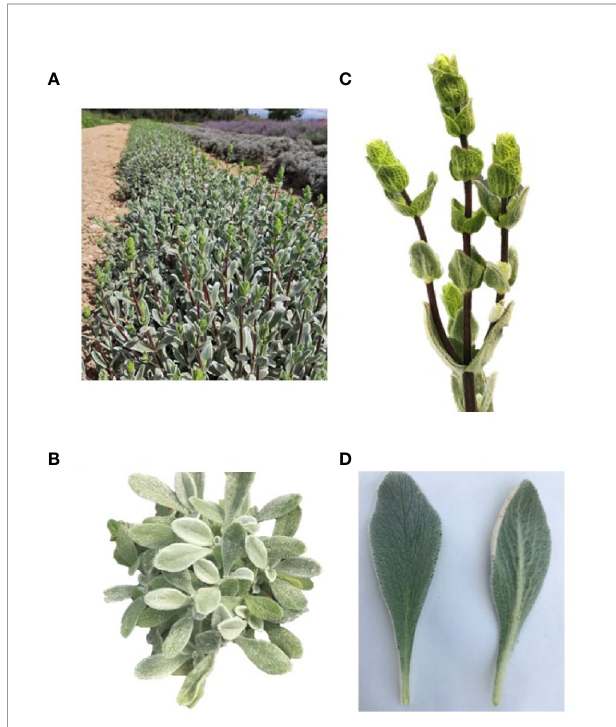
FIGURE 1 | Sideritis cypria , (A) cultivated crop, (B) plant, (C) fl ower, and (D) upper and bottom leaf